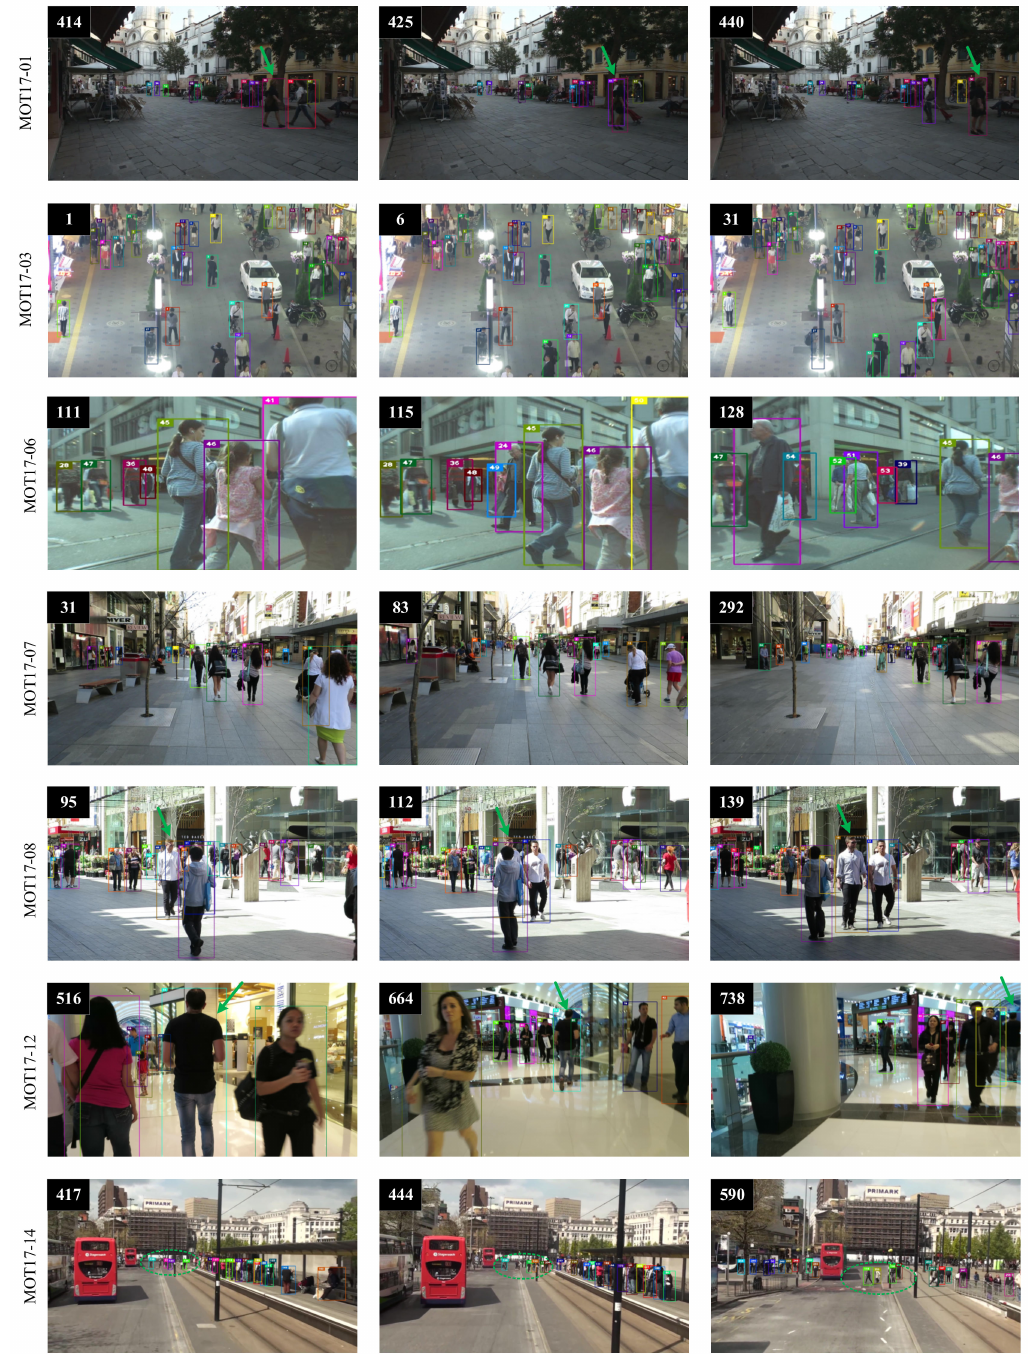
Figure 7. The tracking results of our algorithm on the MOT17 test sequence. In units of rows, from top to bottom are sequence 1, sequence 2, sequence 3, sequence 4, sequence 5, sequence 6, and sequence